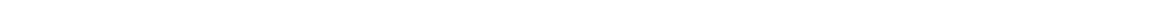
Figure 8 | Bafetinib inhibits TLR-induced cytokine production and signalling in human pDCs. CAL-1 cells ( a ) or human PBMCs ( b – i ) were pre-treated for 1h with bafetinib (5 m M) or DMSO control and then stimulated with R848. ( a , b ) Viability was assessed by flow cytometry, while type I IFN and TNF protein levels in the supernatant were assessed by bioassay and ELISA, respectively, at 15h post-stimulation. ( c , d ) TNF and IFN- a were determined by flow cytometry at 6h post-stimulation. Co-expression of TNF and IFN- a in gated pDCs ( c ). Percentage of pDCs single positive to IFN- a and TNF staining ( d ). MFI of IFN- a and TNF in gated IFN- a þ and TNF þ pDCs ( e ). ( f – i ) The level of p-NF- k B ( f ), p-IRF-7 ( g ), p-p38 ( h ) and p-MTOR ( i ) were assessed by flow cytometry in gated pDCs at 15 ( f , g , i ) or 30 ( h ) min after stimulation. Lines in graph connect the same donor and histograms depict a representative donor; dotted lines, unstimulated; solid lines, R848 stimulation; black line, DMSO; red line, bafetinib treated. Data are representative of five independent experiments ( a ) or four ( b – f ) and five ( g – i ) donors processed separately. Graphs depict mean ± s.d. of replicates within one representative experiment ( a – e ) or individual donors ( f – i ). Dunnett’s multiple comparisons test ( a , b ) and two-ways Student’s t -test ( d – i ) were used for statistical analyses. * P o 0.05, ** P o 0.01, *** P o